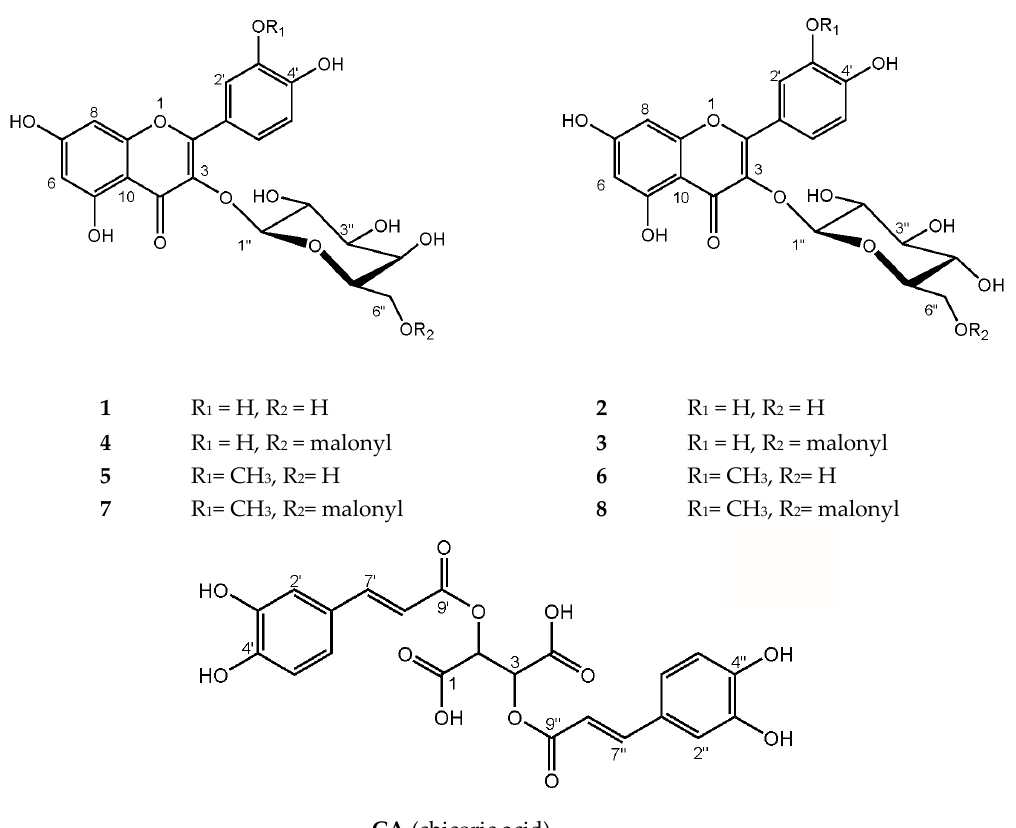
Figure 2. Structures of the main phenolic compounds found in Ruppia cirrhosa and Ruppia maritima . 1 = quercetin 3- O - β - D -galactopyranoside, 2 = quercetin 3- O- β - D - glucopyranoisde, 3 = quercetin 3- O - β - D -(6 ″ - O -malonyl)glucopyranoside, 4 = quercetin 3- O- β - D - (6 ″ - O -malonyl)galactopyranoside, 5 = isorhamnetin 3- O- β - D - galactopyranoside, 6 = isorhamnetin 3- O- β - D - glucopyranoside, 7 = isorhamnetin 3- O- β - D - (6 ″ - O -malonyl)galactopyranoside, 8 = isorhamnetin 3- O - β - D -(6 ″ - O -malonyl)- glucopyranoside, CA = chicoric acid.